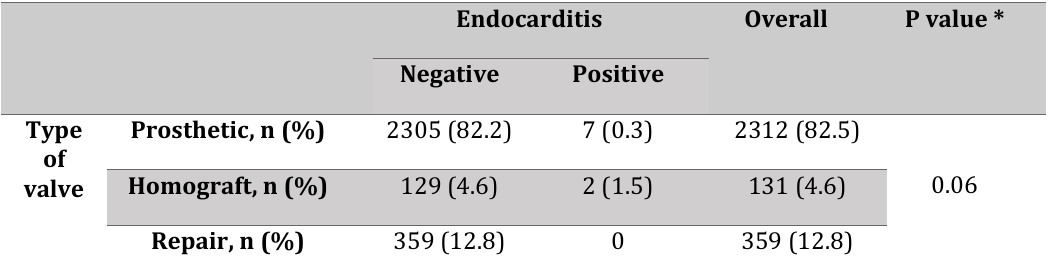
Table 4 . Comparison type of procedure in patients with and without